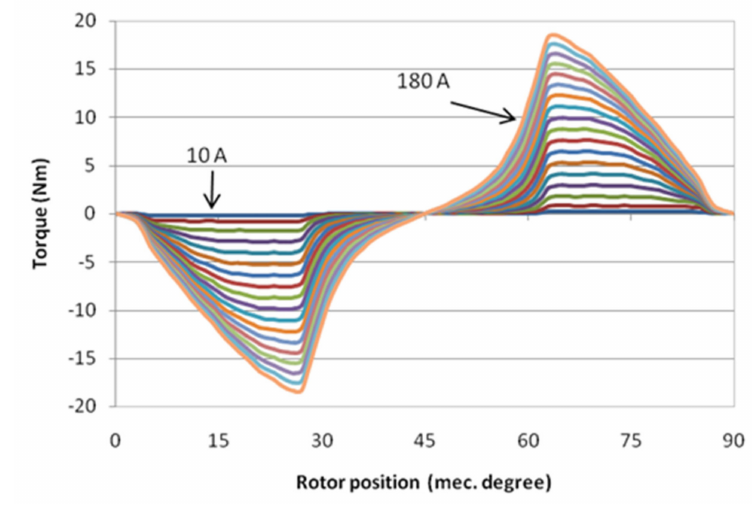
Figure 9. Torque versus current and rotor position.